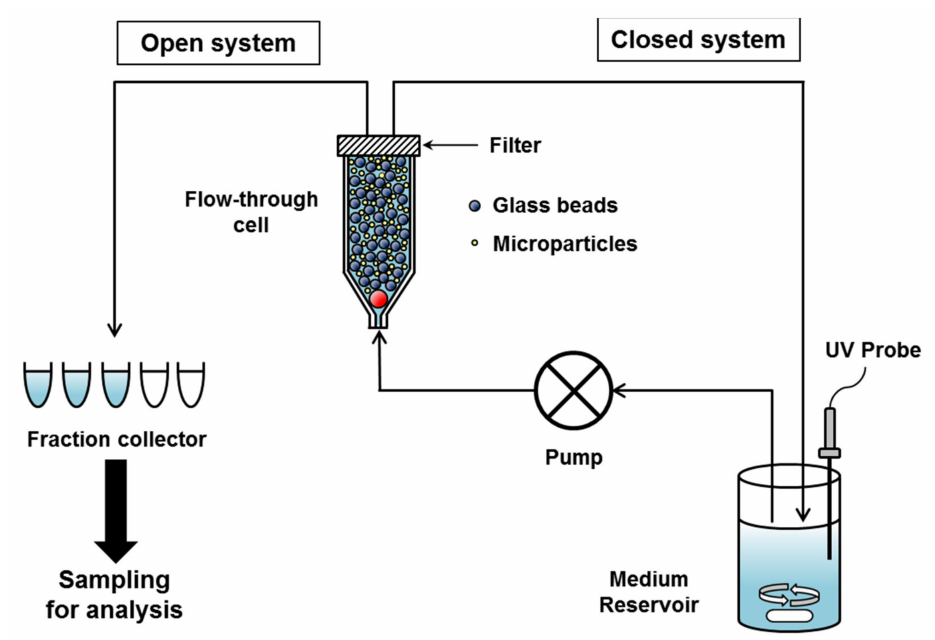
Figure 3. Continuous flow method system for in vitro drug release test of particulate